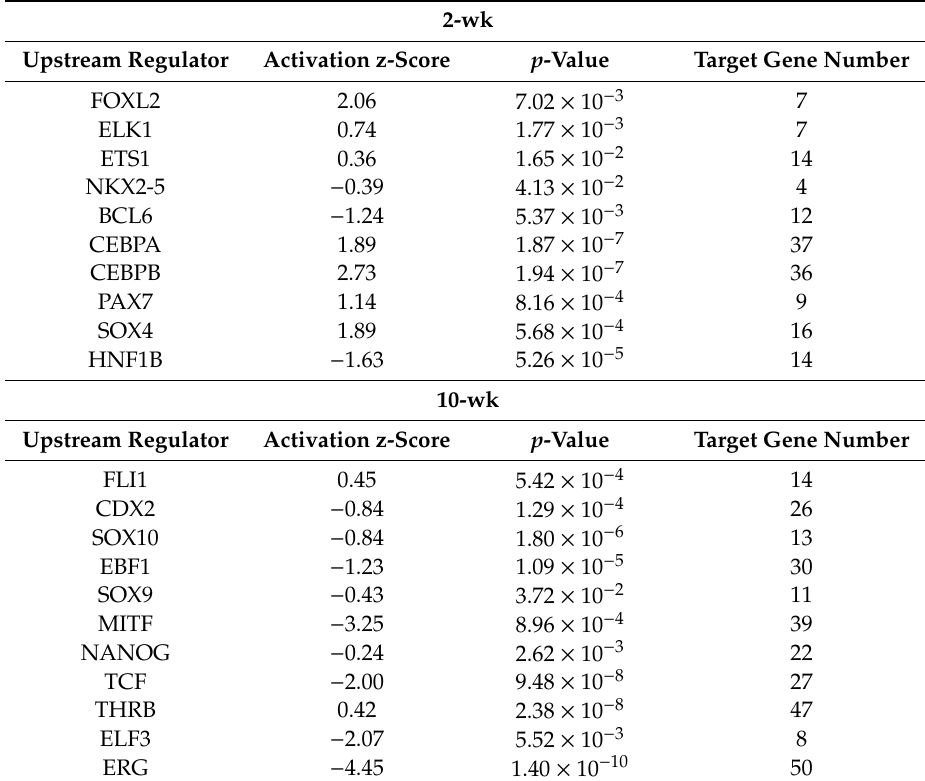
Table 6. Critical upstream regulators identified in transcriptome